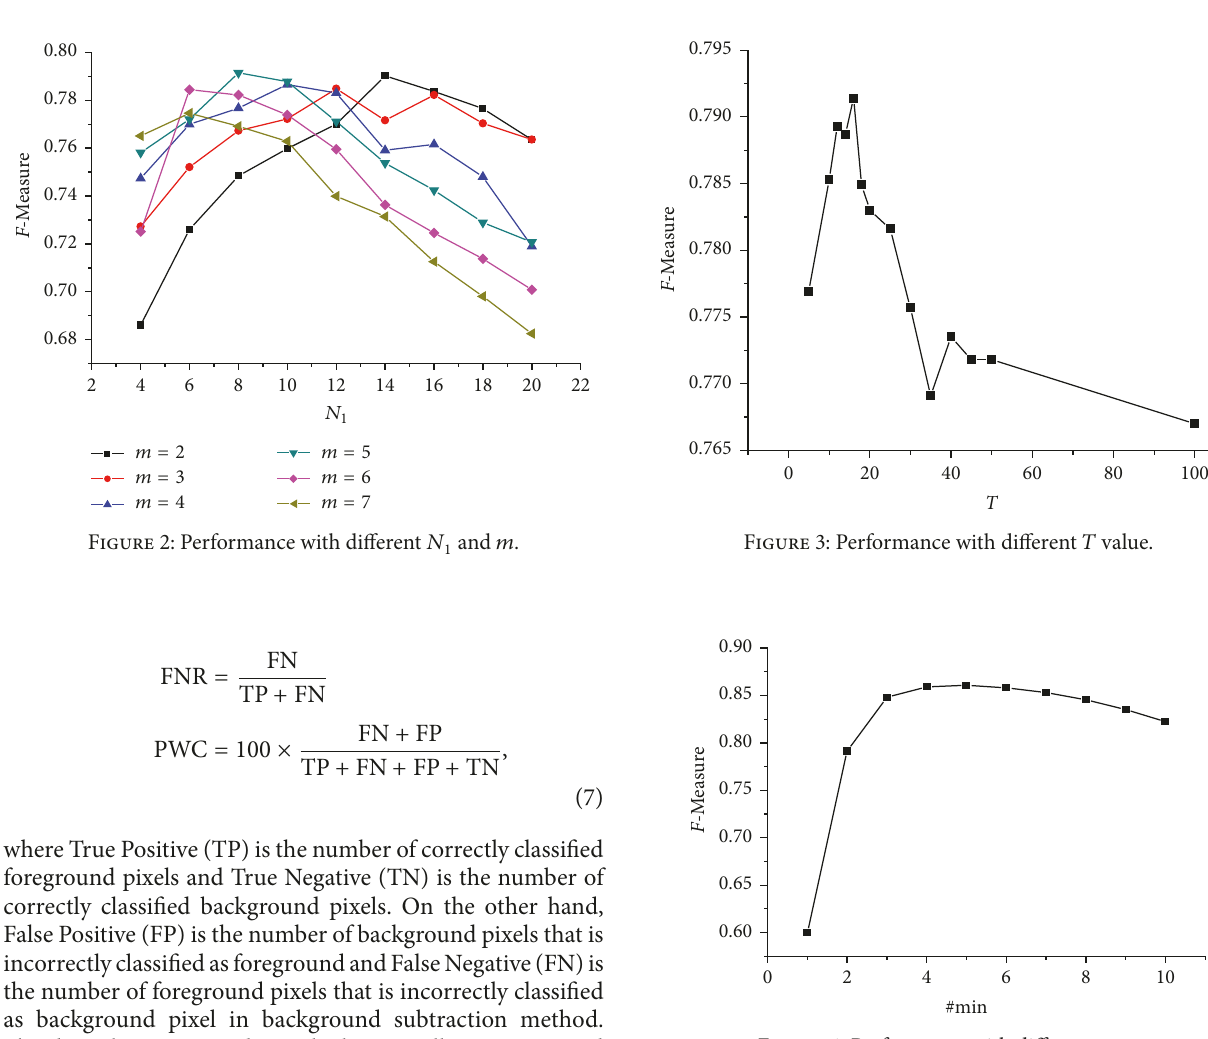
Figure 4: Performance with different # min .